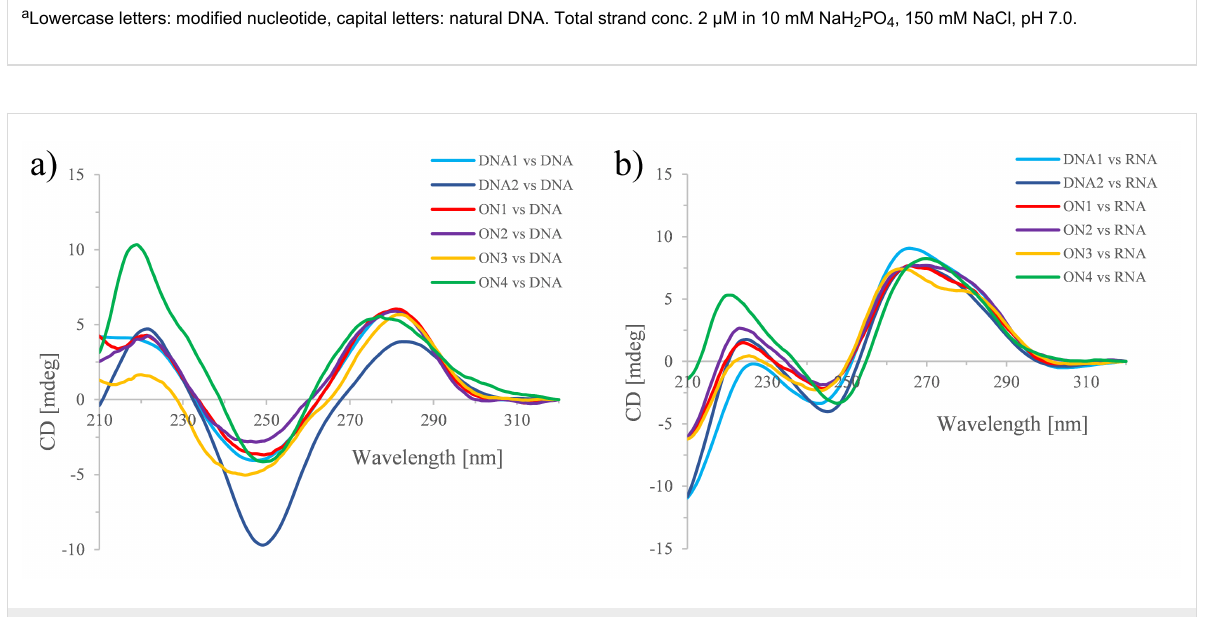
and both intensities were changed, too. Furthermore, the inten- sity of the 210 nm peak was